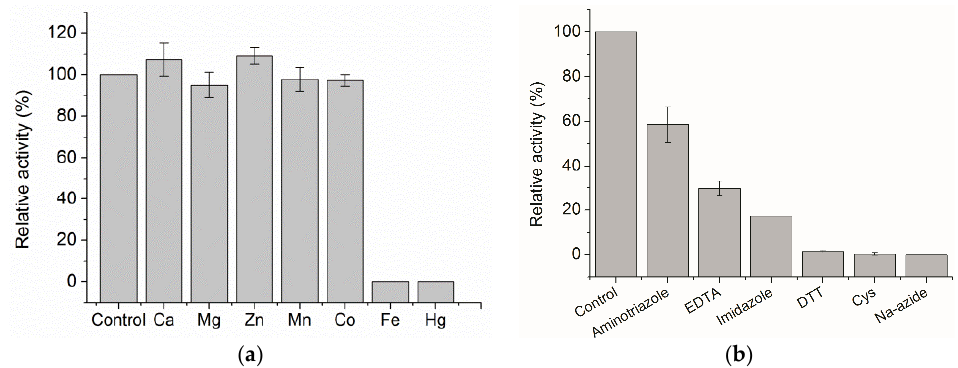
Figure 3. ( a ) The effect of metal ions on activity of Pf DyP B2. ( b ) The effect of inhibitors on the activity of Pf DyP B2. Activity in the absence of inhibitors was taken as 100%.